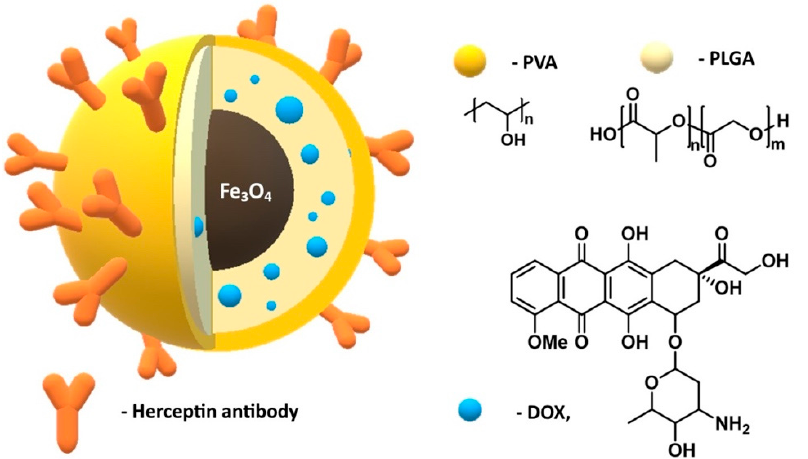
Figure 9. Schematic illustration of magnetic polyoly(D,L-lactide-co-glycolide) (PLGA)/polyvinyl alcohol (PVA)/doxorubicin (DOX) nanoparticles for diagnosis and treatment of cancer. Shubhra and co-authors published a modification of the surface of magnetite nanoparticles coated with poly (D, L-lactide-co-glycolide) with a non-ionic copolymer—poloxamer (Pluronic F68, PF68) for the immobilization of bovine serum albumin (BSA) [145]. The protein adsorption capacity of this material was compared with poly(D,L-lactide- co -glycolide)-coated nanoparticles (Figure 10). The UV-Vis spectrophotometric analysis showed that the BSA adsorption on PF68-modified nanoparticles was reduced by about 50% in relation to poly (D,L-lactide-co-glycolide) modified nanoparticles.